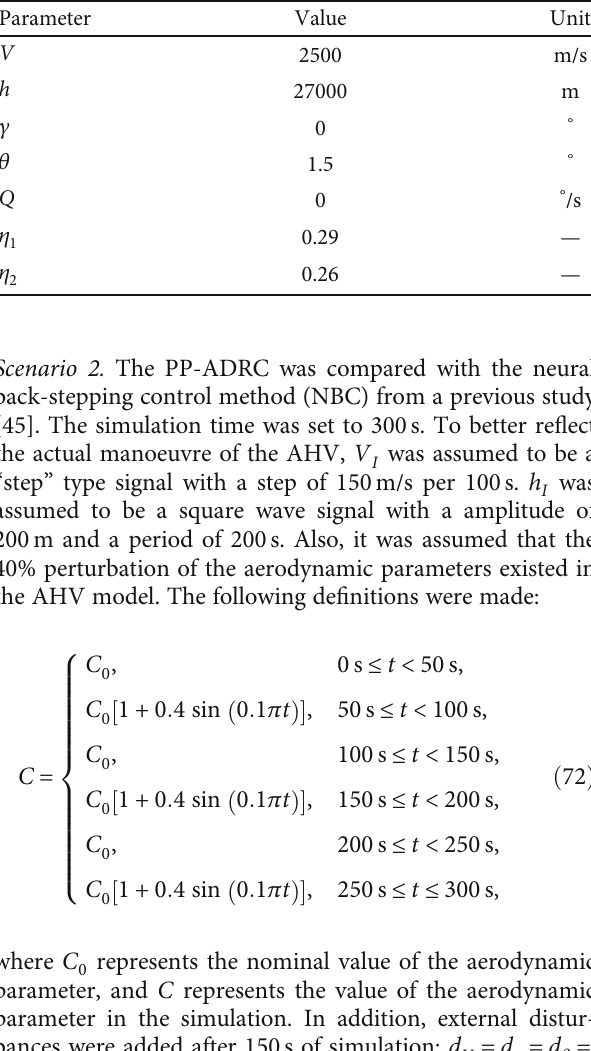
Table 1: Initial values of the AHV state